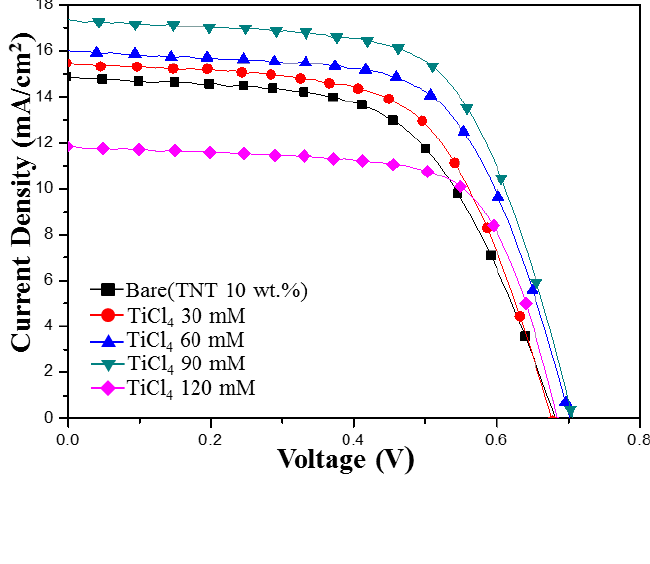
post treated DSSCs for different TiCl 4